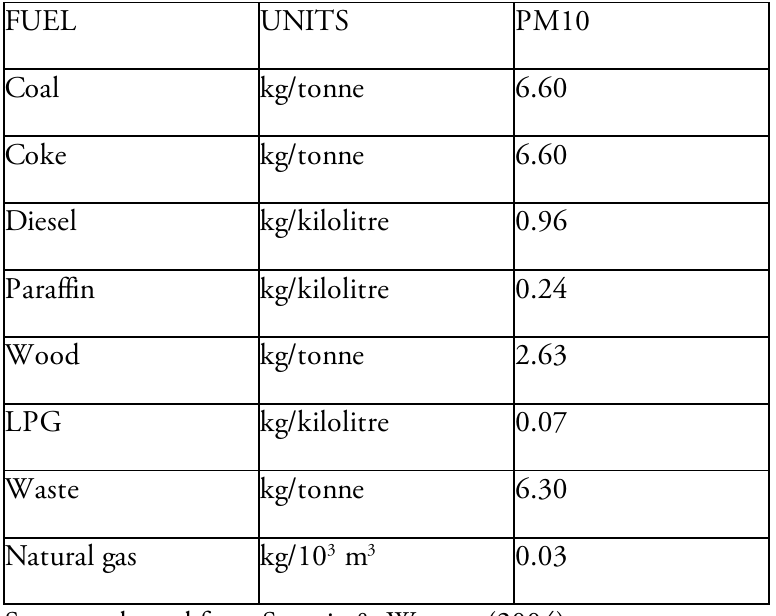
Table 11: PM10 emission factors for household fuel